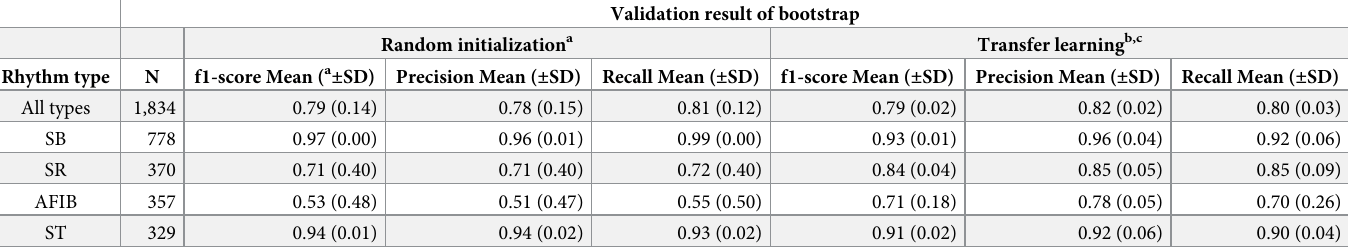
Table 4. Transfer learning vs. random initialization using the bootstrap validation method.